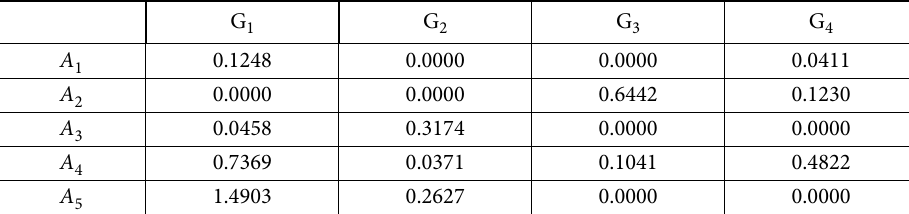
Table 7. The results of NDA